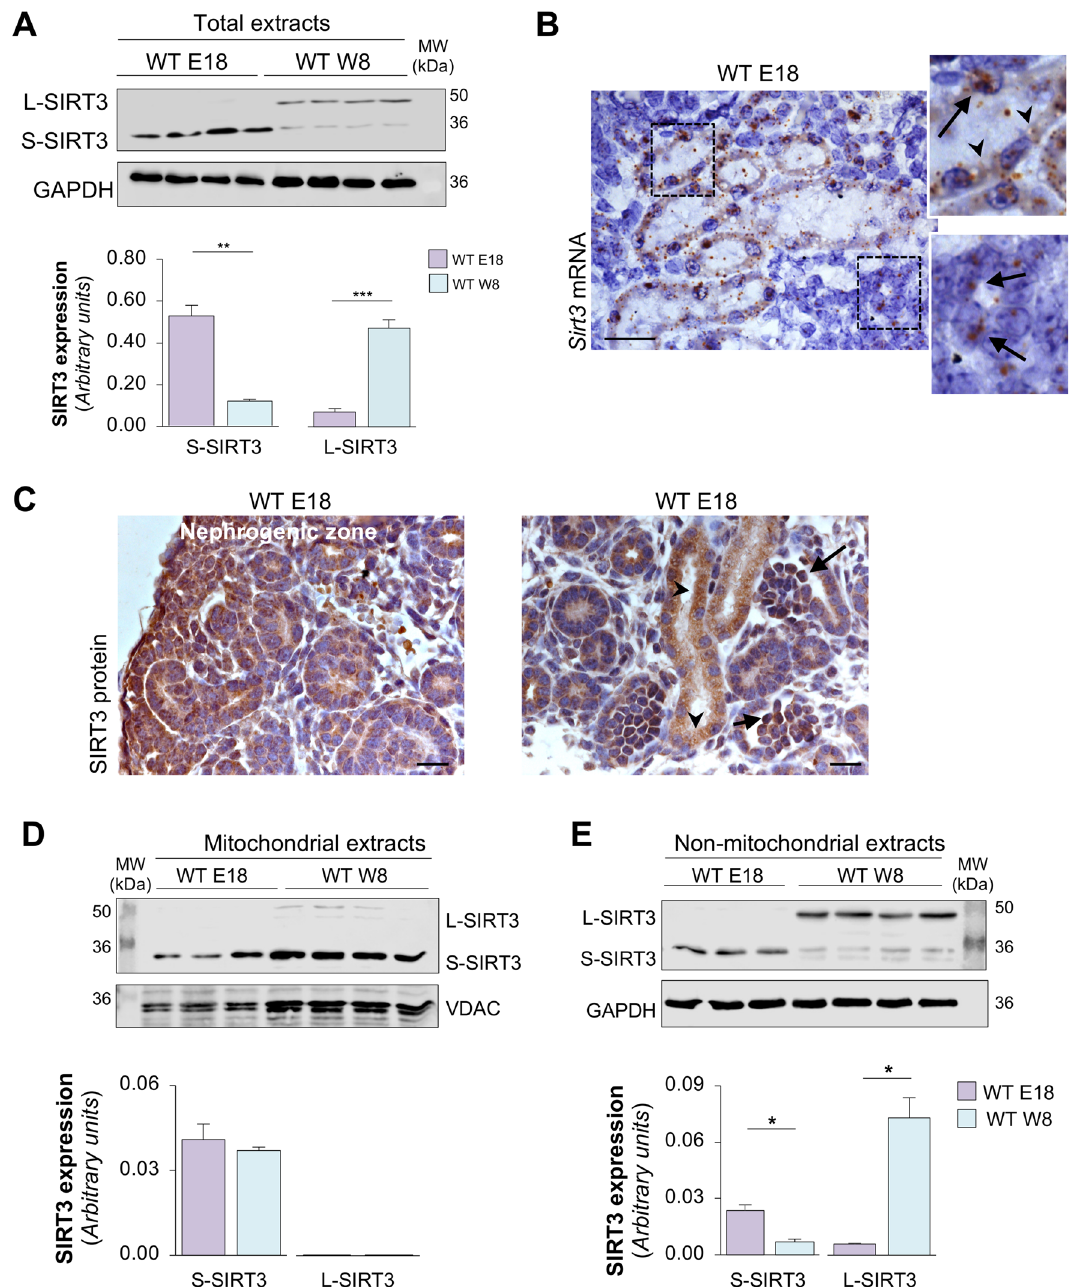
Figure 2. SIRT3 expression pattern changes during different kidney maturation stages. ( A ) Representative Western blots and densitometric analysis of S-SIRT3 and L-SIRT3 isoform expression in total extracts of kidneys on E18 and at W8 ( n = 4 samples per group). For E18 extracts, each sample is the pool of 5 kidneys. For W8 extracts, each sample is a single mouse kidney. GAPDH was used as sample loading control. ( B ) Representative images of in situ hybridisation for Sirt3 mRNA in kidney from WT mice on E18. Insets show the localisation of Sirt3 mRNA in the cytoplasm (arrowheads) and nuclei (arrows) of more differentiated renal structures while Sirt3 mRNA expression is mainly localised in the nuclei of still immature structures (arrows, n = 3 mice per group). Scale bar, 20 μm. ( C ) Representative immunohistochemistry images of SIRT3 protein expression on E18 showing high nuclear SIRT3 expression in the nephrogenic zone, localised in the outer kidney cortex (left panel) and in immature structures (arrows, right panel), as opposed to the cytoplasmic localisation of SIRT3 in developed tubular structures, possibly reflecting a mitochondrial localisation (arrowheads, right panel ; n = 3 mice per group). Scale bar, 20 μm. ( D , E ) Representative Western blots and densitometric analysis of the expression of SIRT3 isoforms in ( D ) isolated mitochondrial and ( E ) non-mitochondrial extracts harvested from WT kidney on E18 and at W8 ( n = 3 samples per group). For E18 extracts, each sample is the pool of 5 kidneys. For W8 extracts, each sample is a single kidney. Voltage-dependent anion-selective channel 1 (VDAC) and GAPDH were used as sample loading controls for mitochondrial and non-mitochondrial extracts, respectively. Molecular weights (MW) are reported in each representative Western Blot and expressed in kDa. Data represent mean ± s.e.m. and were analysed with Student’s t -test. * P < 0.05, * P < 0.01, and *** P <